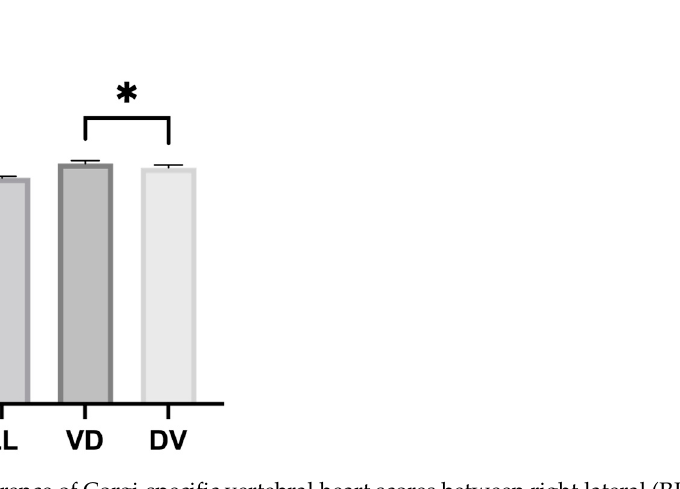
Figure 3. The mean difference of Corgi-specific vertebral heart scores between right lateral (RL), left lateral (LL), ventrodorsal (VD), and dorsoventral (DV) positions (* significantly different, p < 0.05).